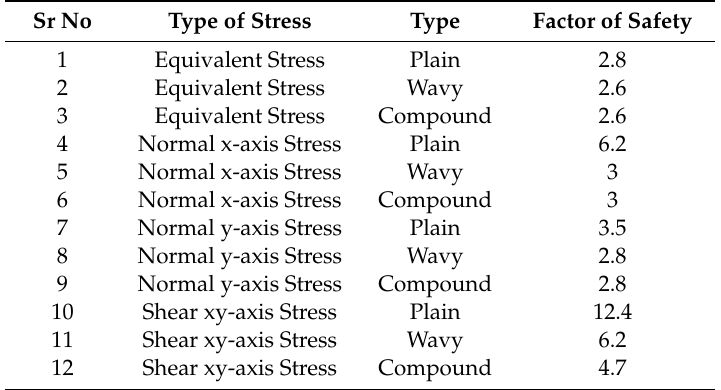
Table 5. Factor of safety along path 3 for plain, wavy and compound configuration. Sr